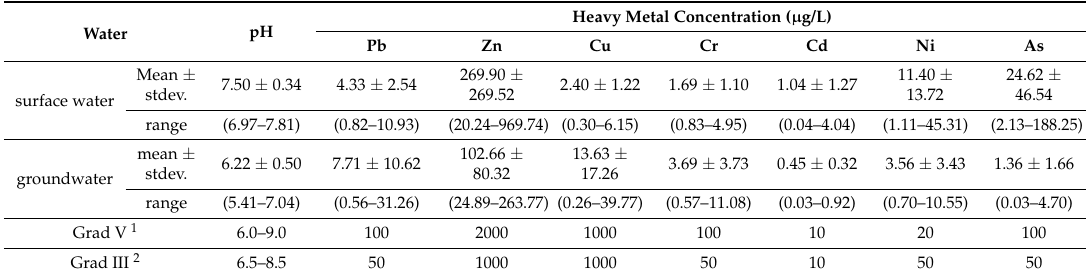
Table 3. Heavy metal concentration in water samples ( µ